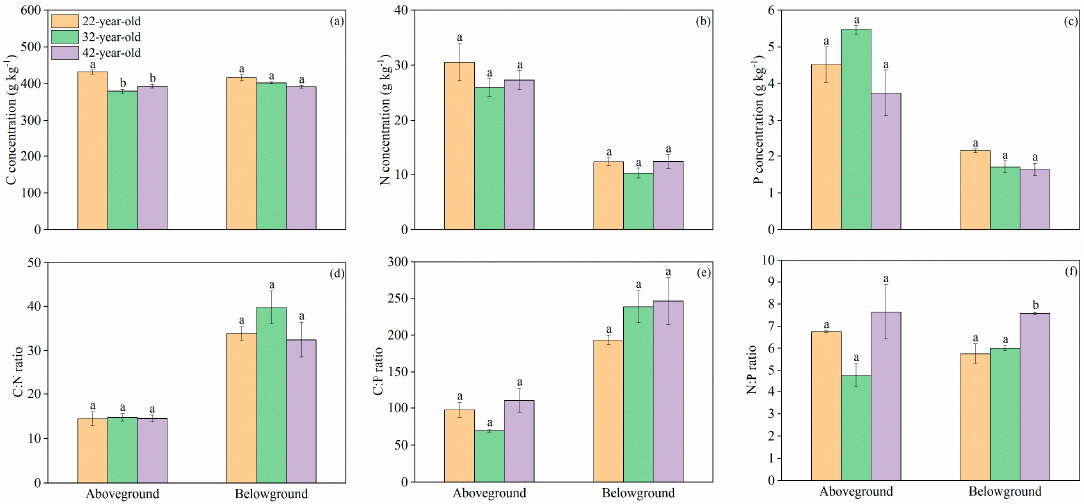
Figure 5. ( a ) C concentration, ( b ) N concentration, ( c ) P concentration, ( d ) C:N, ( e ) C:P and ( f ) N:P in the herb biomass of three different aged P. asperata plantations. Different lowercase letters indicate a significant difference between different aged stands for the same variable ( p < 0.05).